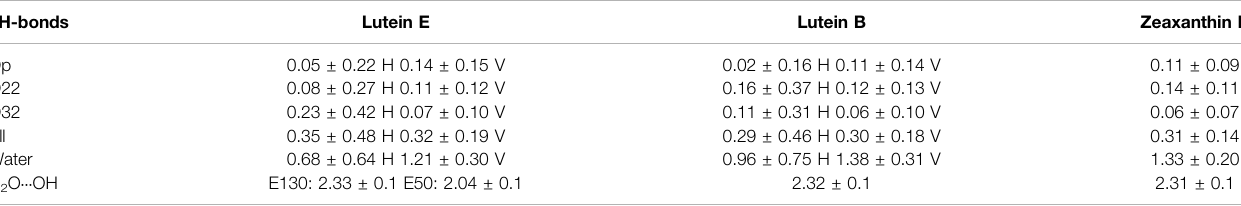
TABLE 1 | Numbers of H-bonds of XAN-OH.